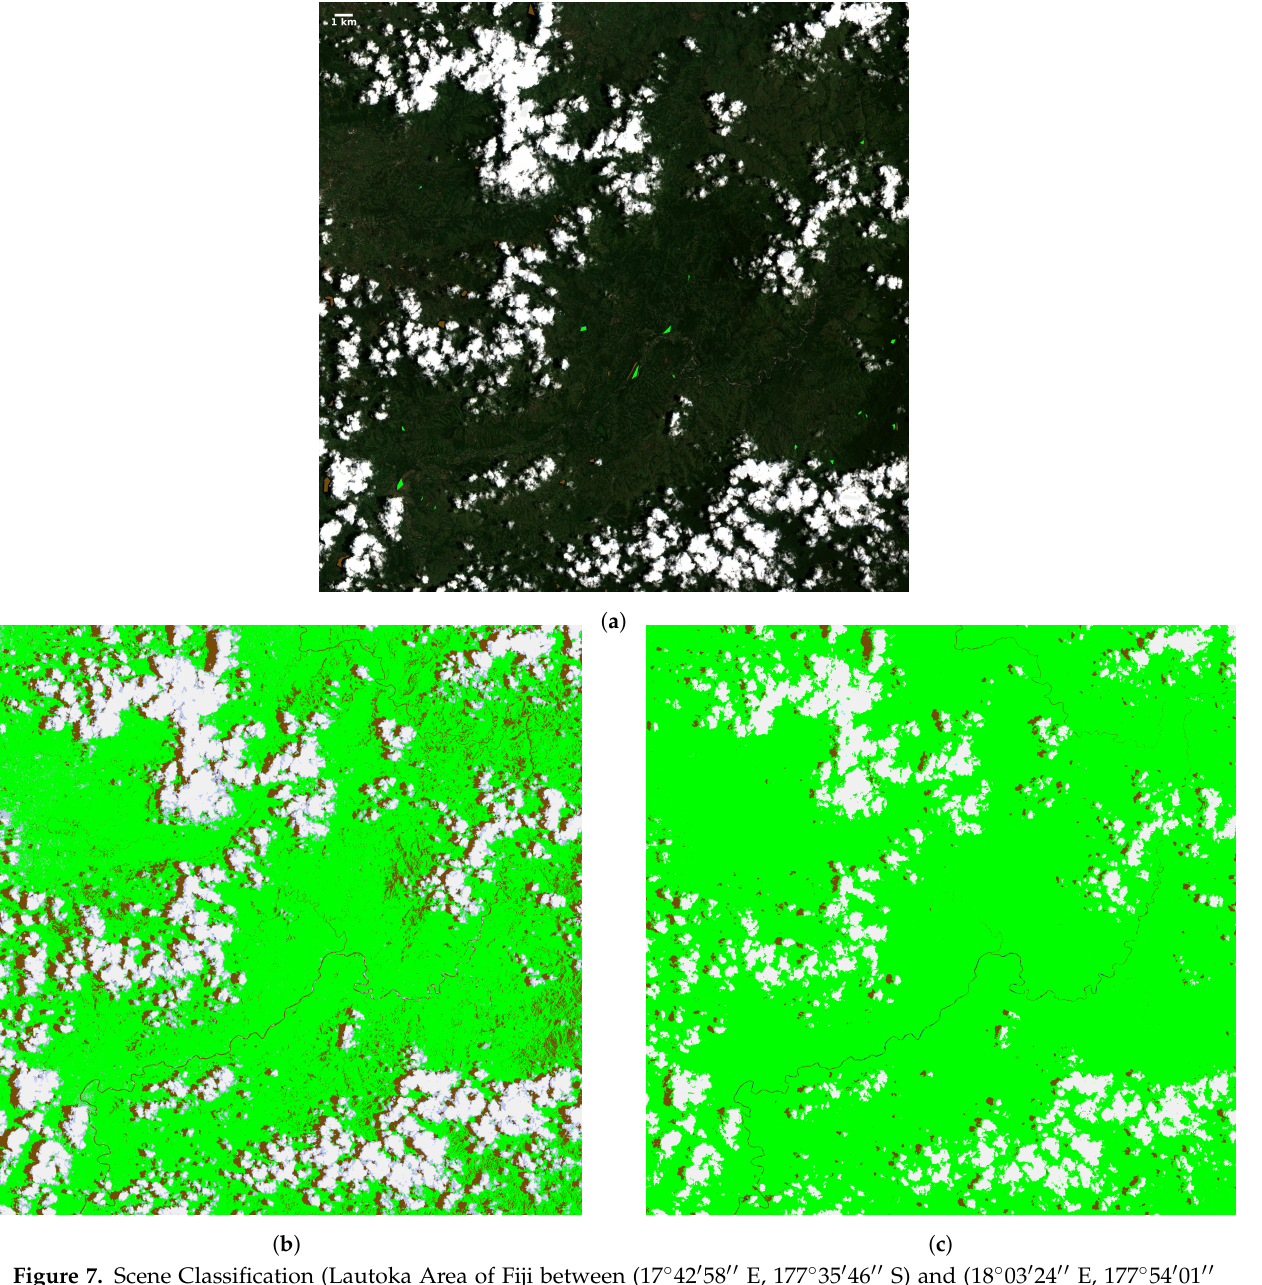
Figure 7. Scene Classification (Lautoka Area of Fiji between (17 ◦ 42 (cid:48) 58 (cid:48)(cid:48) E, 177 ◦ 35 (cid:48) 46 (cid:48)(cid:48) S) and (18 ◦ 03 (cid:48) 24 (cid:48)(cid:48) E, 177 ◦ 54 (cid:48) 01 (cid:48)(cid:48) S) coordinates): ( a ) RGB Image, ( b ) ET classifier, and ( c ) Sen2Cor. Color Labels: Cloud (White), Shadow (Brown), Other